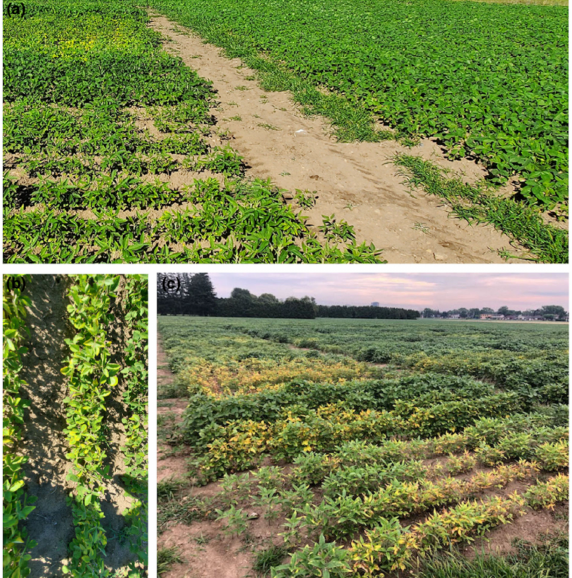
Figure 2. Soybean field in Agriculture and Agri-Food Canada, Ottawa Research and Development Centre (AAFC-ORDC) post SCN infection at different stages. ( a ) Soybean during early infection still appear relatively healthy; ( b ) leaf chlorosis and yellowing then becomes visible; ( c ) soybean plants become yellow and die during later stages of